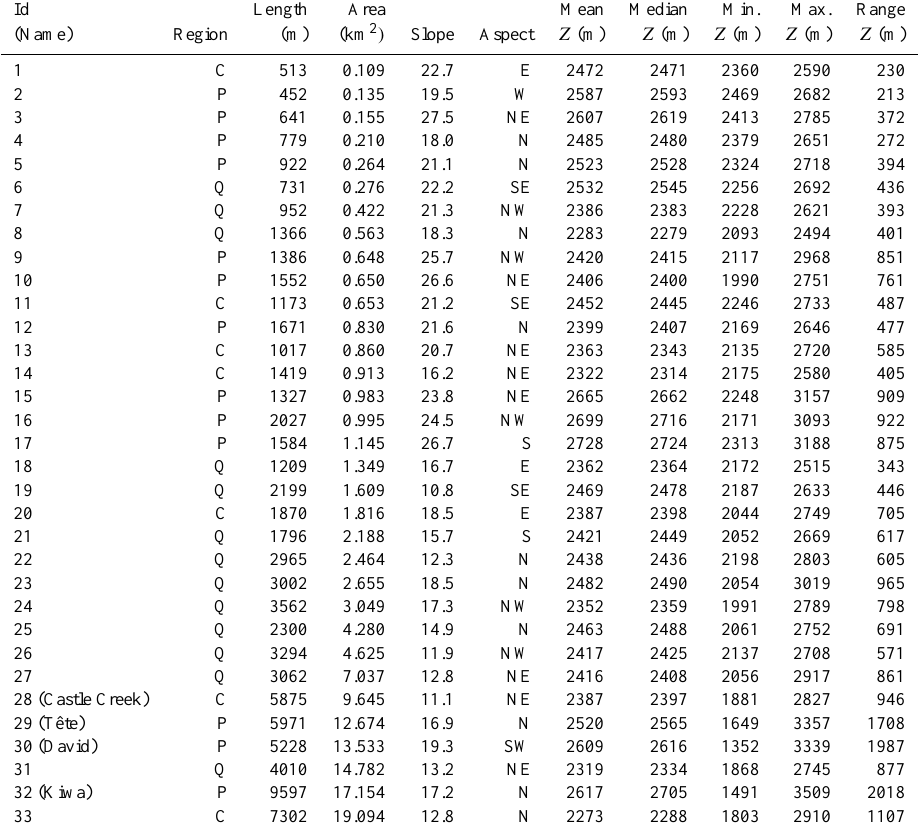
Table 2. Morphometric properties of the 33-glacier